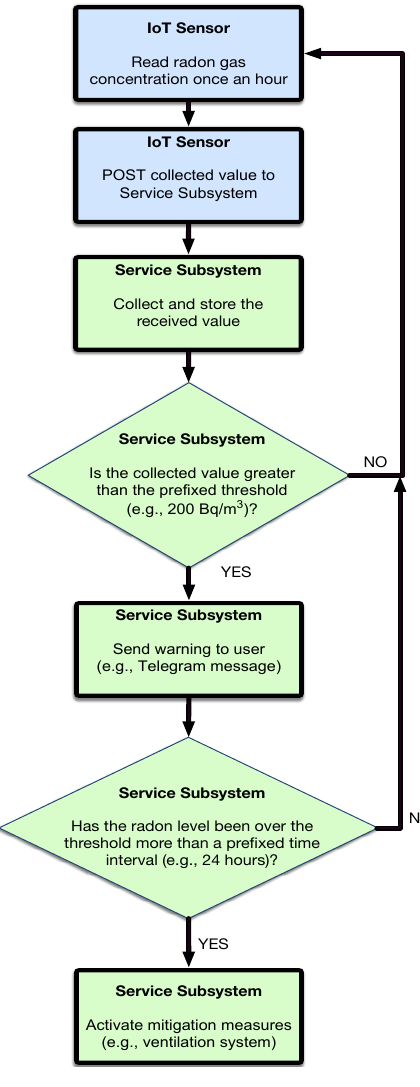
Figure 10. Control flow of the tested